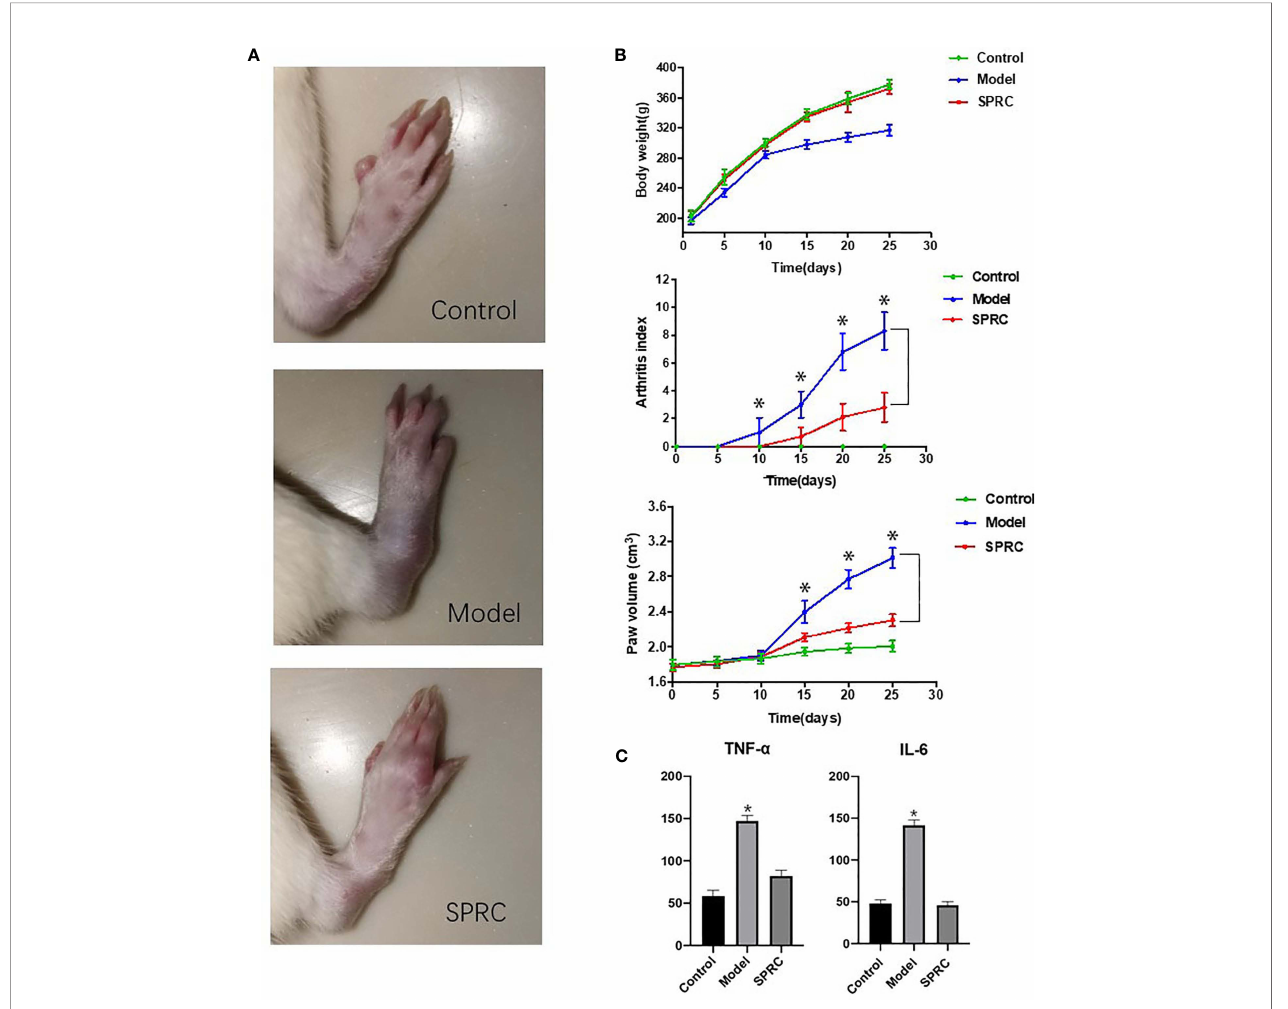
FIGURE 1 | SPRC ameliorated symptoms of arthritis in AIA rats. (A) The representative paws of rats in the Control, Model, and SPRC-treated groups. (B) Body weight, arthritis index, and paw volume were also recorded, with green lines representing the Control group, blue lines representing the Model group, and red lines representing the SPRC group. The marked asterisks (*) indicated signi fi cant differences (p < 0.05) between groups (n=10, means ± SD). (C) TNF- a and IL-6 levels were also detected, with asterisks (*) indicating p < 0.05 compared with the Control group (n=10, means ±